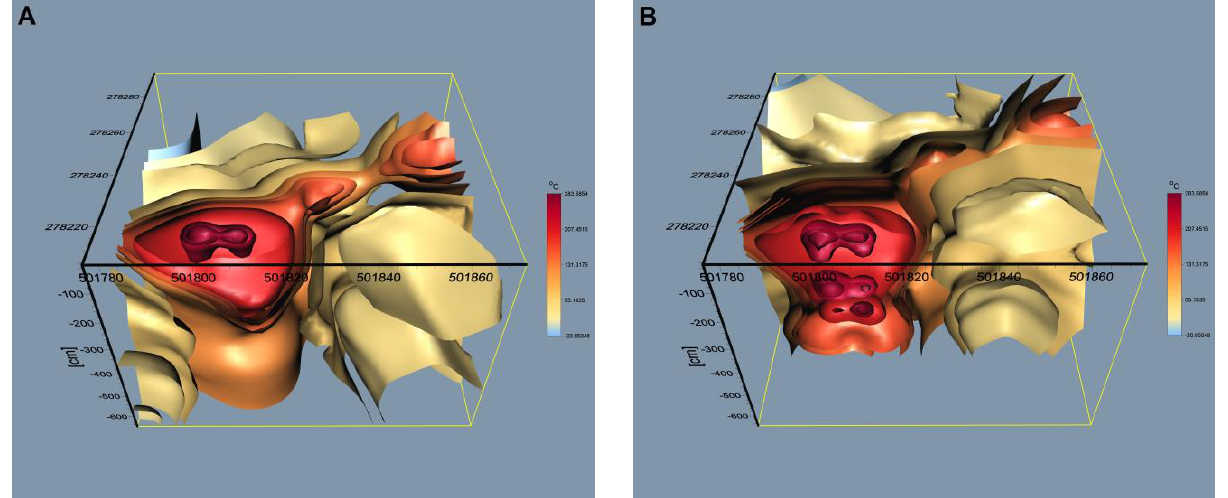
Fig. 7. 3D model, visualizing the temperature distribution inside the "Wojkowice" spoil tip; ETRS89/Poland CS92: A – coordinates on the Z axis; B – coordinates on the Y